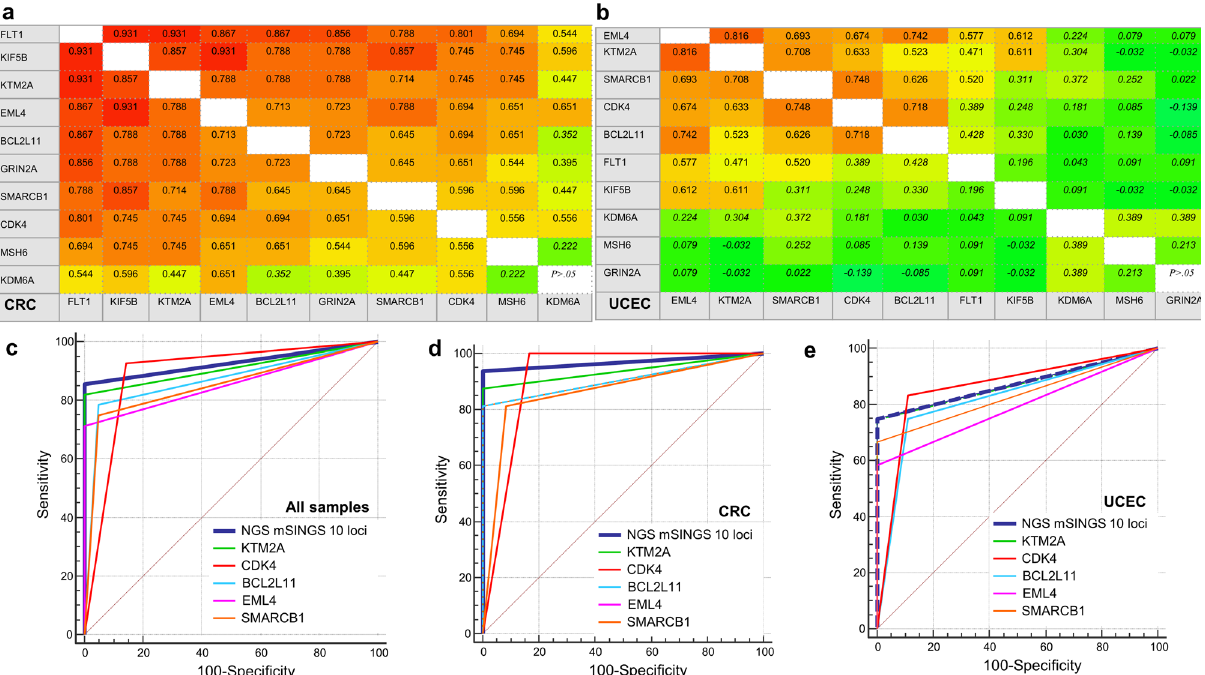
Figure 3. functional redundancy in diagnostic performance of individual loci and overall inferior performance of all loci in endometrial versus colorectal cancers. Figure 3 shows the results of the 10 loci in the NGS assay but similar data were obtained for PCR and Idylla MSI assay. Panel ( a ) and ( b ) show correlation tables with non-parametric Spearman rank correlation coefficients of AUC of individual microsatellite loci for detection of dMMR status versus IHC in CRC ( a ) and UCEC ( b ). Coefficients in italic font indicate non statistically significant correlation ( P > 0.05). Coefficients colored according to the magnitude of the correlation. Loci with the highest inter-correlation also ranked among the highest AUC (Table 2). Panel c shows graphic plot of AUC of the integrated NGS result over 10 loci (thick blue line) versus the 5 loci with the highest individual AUC over all 49 samples ( c ). Panel d and e plot AUC in CRC (n = 28) and UCEC (n = 21) separately. Plots created by MedCalc (version 12.2.1, www. medca lc.